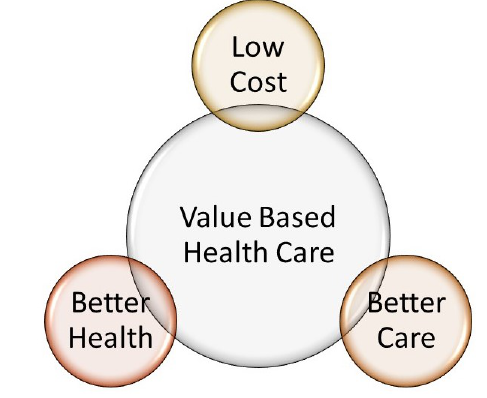
Figure 1. Value-based Healthcare and Triple Aim